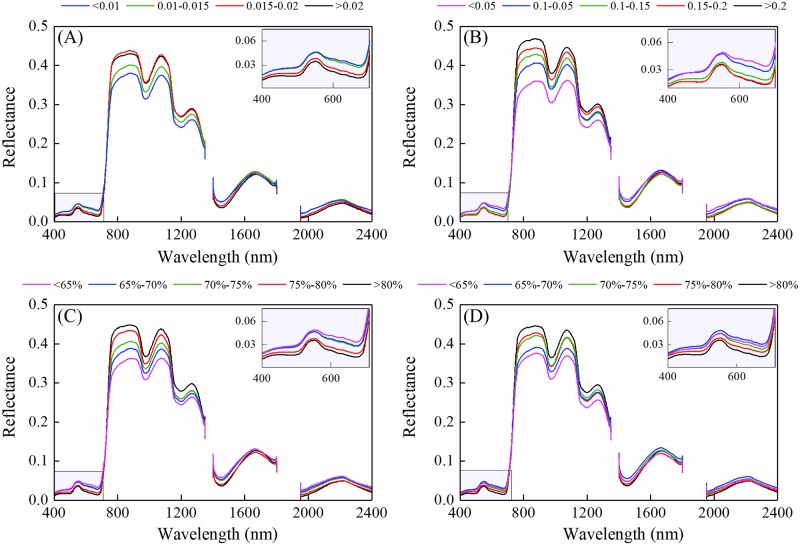
Canopy spectral reflectance (raw data) at various plant water status in winter wheat.Different colors indicate the mean spectrum of various gradients of water metrics. (A) equivalent water thickness (EWT), (B) canopy water content (CWC), (C)leaf water content (LWC) and (D) plant water content (PWC).